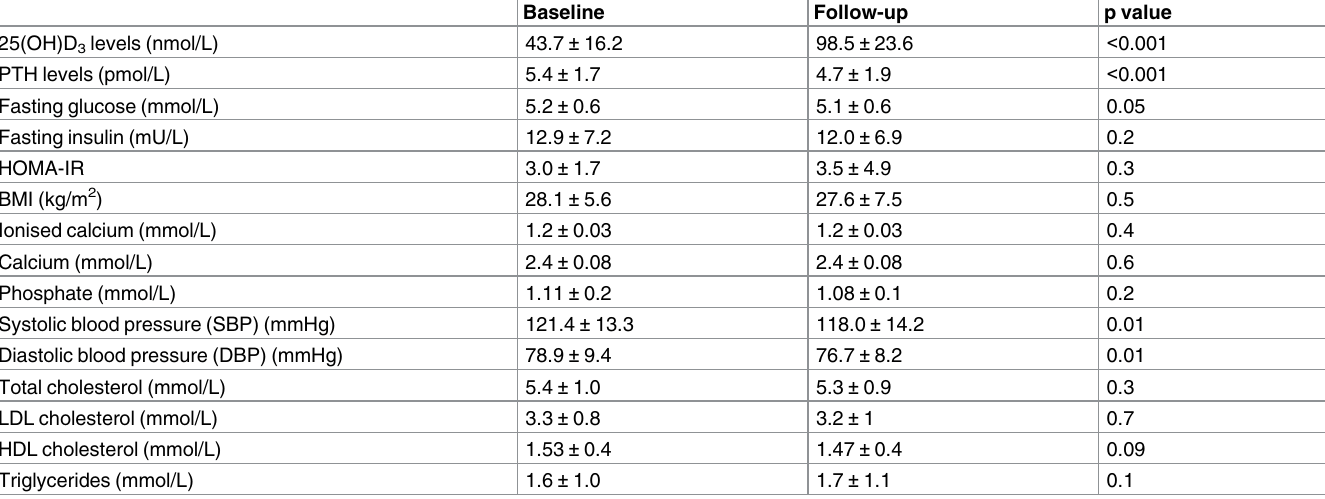
Table 1. Clinical characteristics of subjects at baseline and after 12 weeks of vitamin D